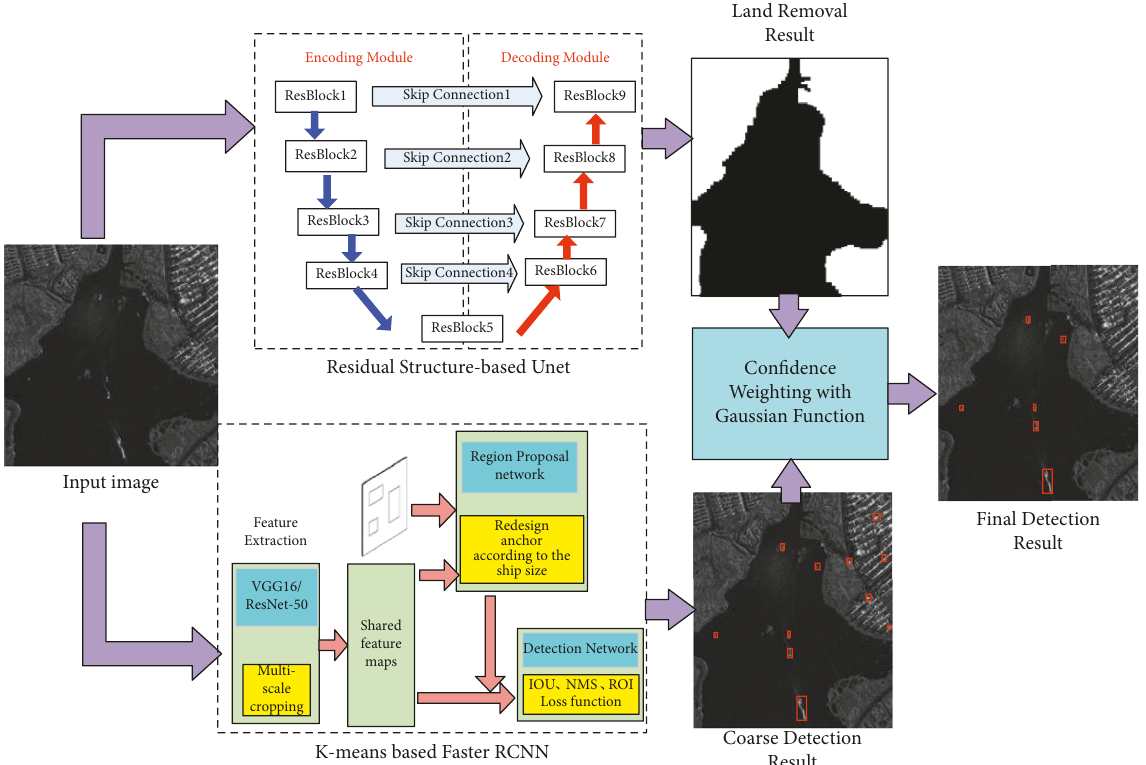
Figure 6: Flow chart of the proposed method.